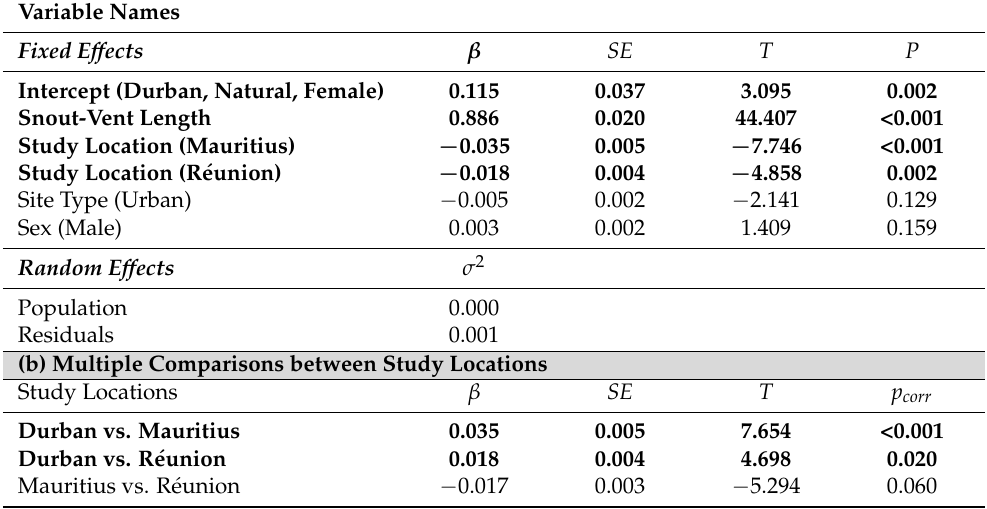
Table 4. ( a ) Outcome of the LMM examining differences in guttural toad ( Sclerophrys gutturalis ) hindlimb length (mm). All coefficient estimates are representative of log 10 -transformed morphological measures. Since the interaction between study location and site type was not significant, it was removed and the models were re-run. Coefficient estimates ( β ) of fixed effects are presented with their corresponding standard errors ( SE ), variance estimates ( σ 2 ) are supplied for residuals and random effects, and all significant values ( p < 0.05) are bolded. Reference levels for each categorical variable are supplied in brackets following the variable name. ( b ) Post hoc multiple comparisons of hindlimb length between all study locations; in this case, p -values ( p corr ) were corrected using an “ mvt ” adjustment